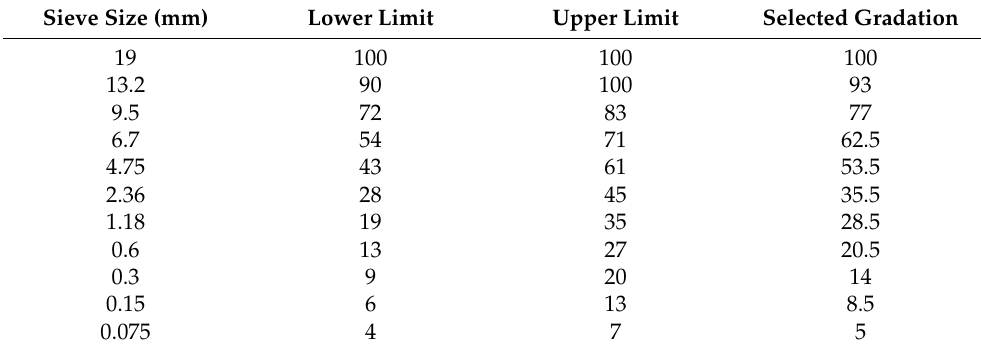
Table 3. Particle size distribution of the